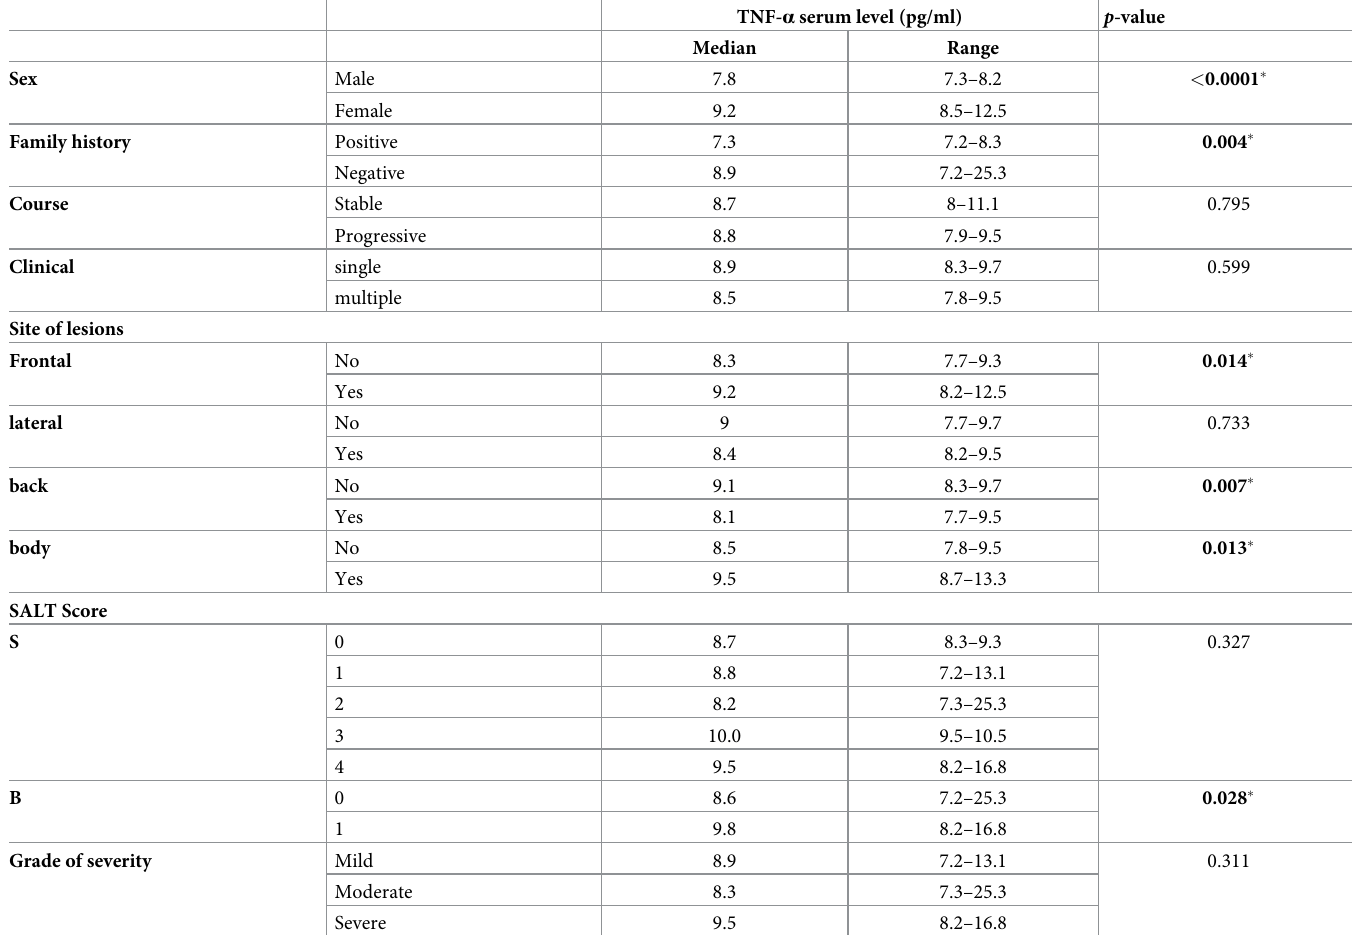
Table 2. Differences in TNF- α serum level (pg/ml) in relation to clinical data in alopecia areata